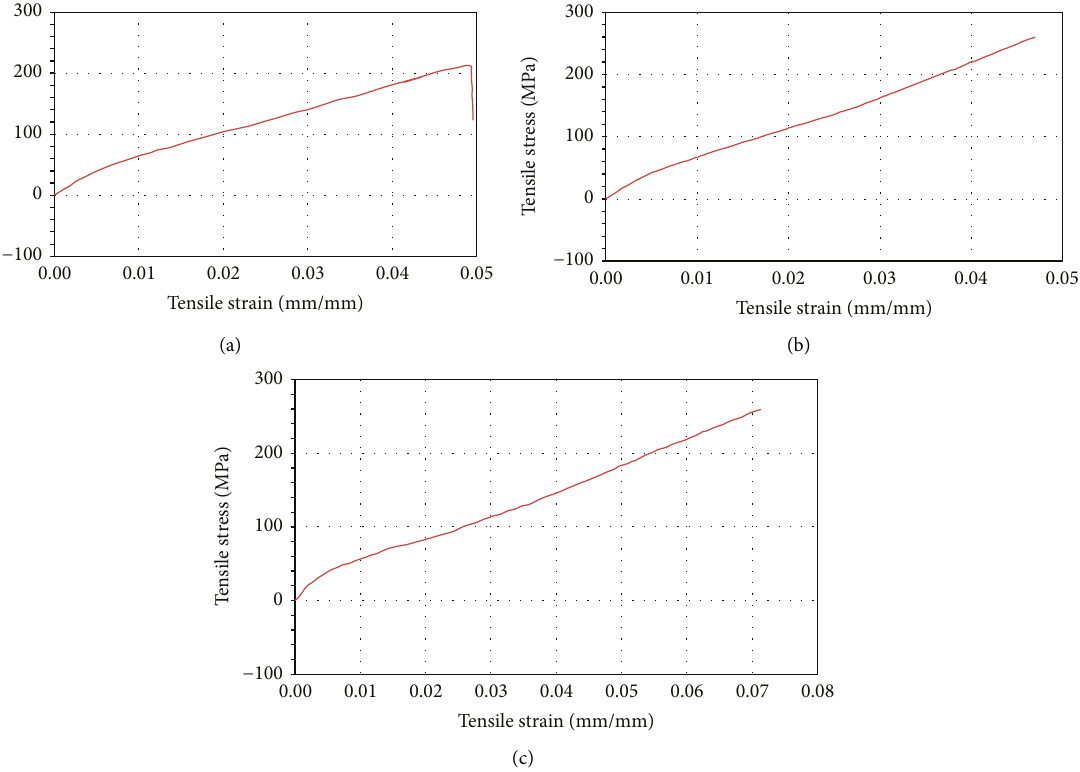
Figure 6: Tensile behavior of (a) 50/50%, (b) 60/40%, and (c) 70/30% glass/epoxy